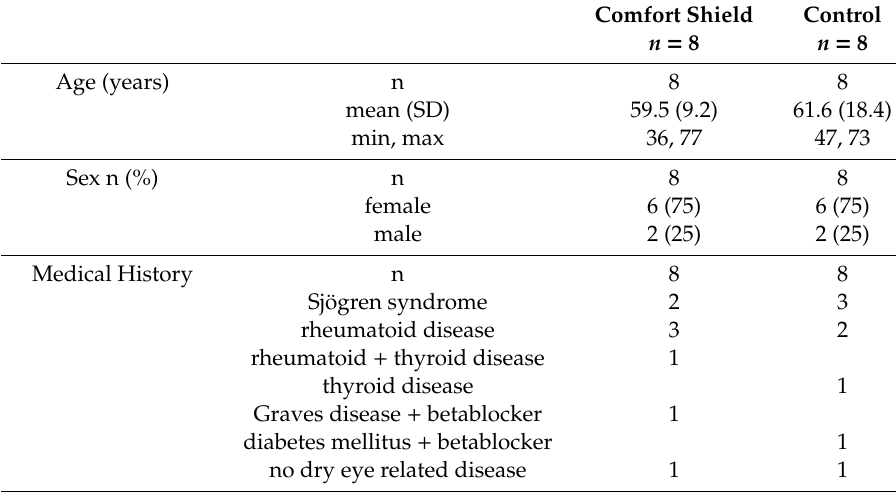
Table 2. Socio-demographic characteristics according to the treatment arm ( n = 16).